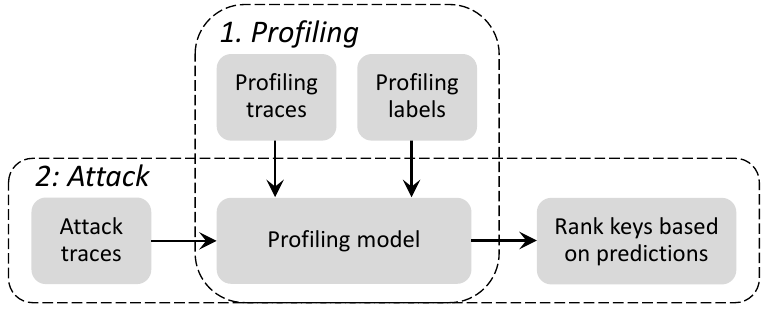
Figure 1: Profiling side-channel